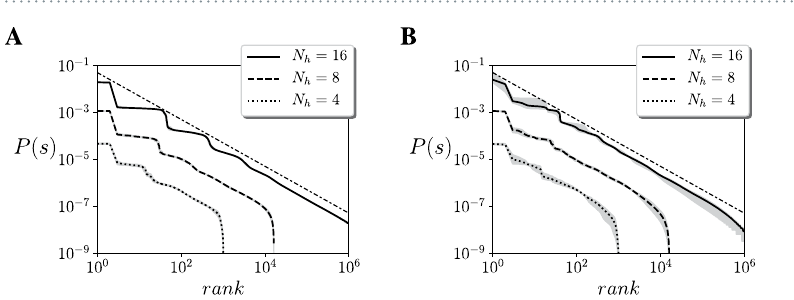
Figure 5. ( A , B ) Entropy of the sensor units for different sizes up to N = 70 ( N h = 64), for 10 different agents and 101 values of β . (C,D) Heat capacity of the agent’s neurons. Heat capacity computed as C ( ) H ( ) β β = − β H ( β ) is estimated using B-splines. Maximum and minimum values are shown by the grey area. The figures suggest that in both the Mountain Car (left) and Acrobot (right) embodiments the system presents a divergence of its heat capacity as the number of neurons N increases, suggesting that the neural controller of the system is near a second order phase transition.